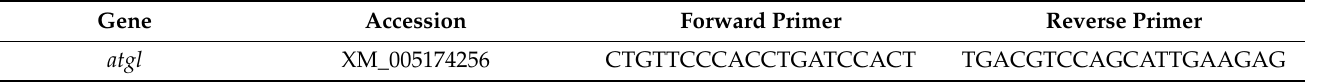
Table 1. Primer sequences used for in-situ hybridization